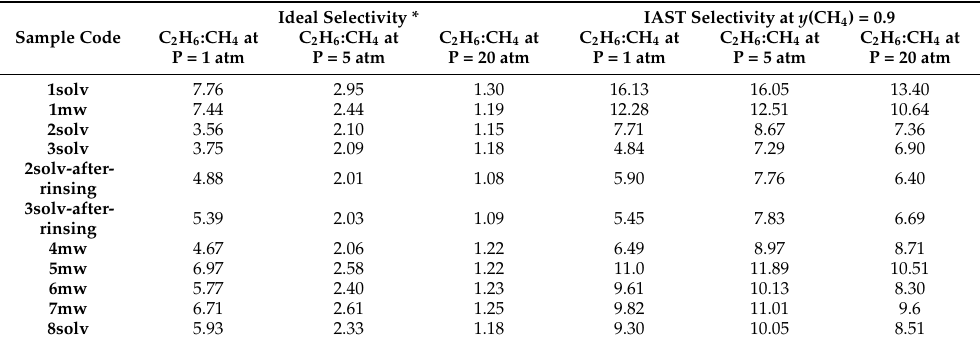
Table 4. Ideal selectivity for methane and ethane for obtained samples of HKUST-1.